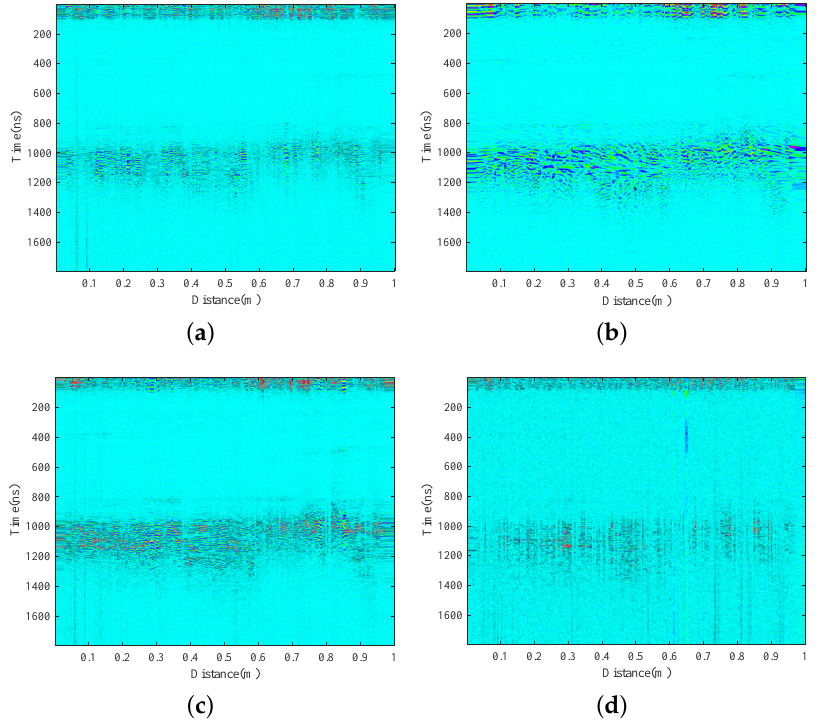
Figure 22. The IMFs obtained by WOA-VMD-BD of the measured data in HH polarization mode. ( a ) IMF1. ( b ) IMF2. ( c ) IMF3. ( d ) IMF4.